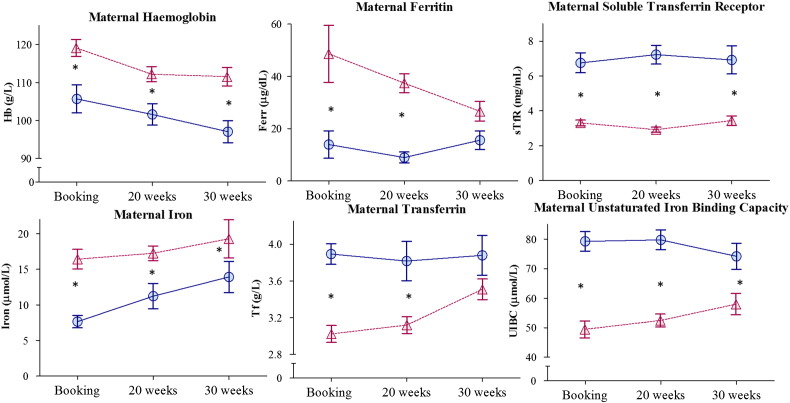
Maternal biochemistry. Mothers selected based on soluble transferring receptor (sTfR mg/L)/log ferritin (Ferr μg/L) index at 20 wk gestation: sTfR/log Ferr > 2.0 = Low Iron (blue circles), sTfR/log Ferr < 1.5 = Normal Iron (pink triangles). * indicates a significant difference between groups (P < 0.05) using least-squares post hoc tests as in Table 1.